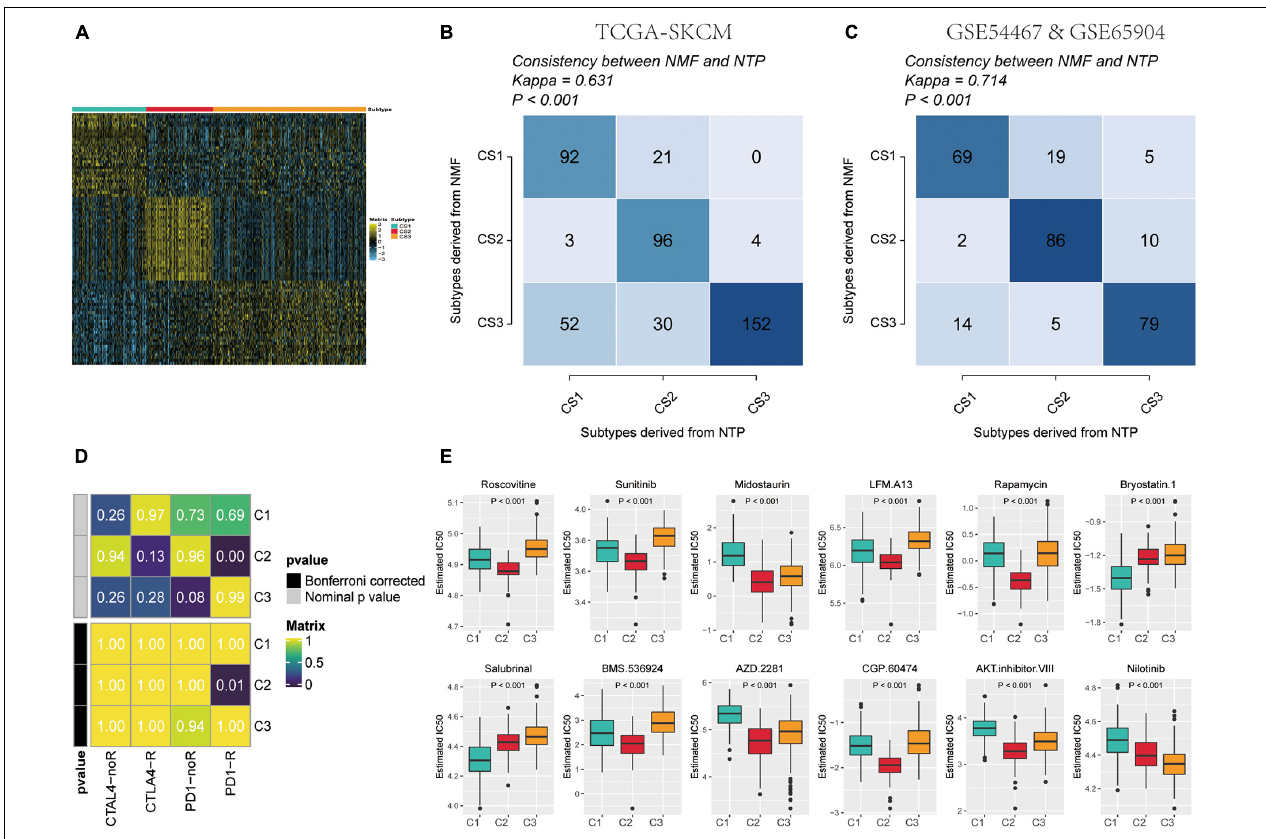
FIGURE 7 | Identification of predictive metabolism-gene classifier and prediction immunotherapeutic response. (A) The heat map exhibited the expression level of the 90-gene classifier in C1, C2, and C3. (B) Consistency of SKCM metabolism subtype predictions between the 90-gene classifier and the original NMF-based predictions in TCGA-SKCM. (C) Consistency of SKCM metabolism subtype predictions between the 90-gene classifier and the original NMF-based predictions in GSE54467 and GSE65904. (D) C2 is likely sensitive to the PD-1 receptor inhibitor (nominal p = 0.01) by SubMap analysis. (E) Top 12 box plots of predicted IC50 values based on GDSC database drugs in three subtypes of TCGA-SKCM